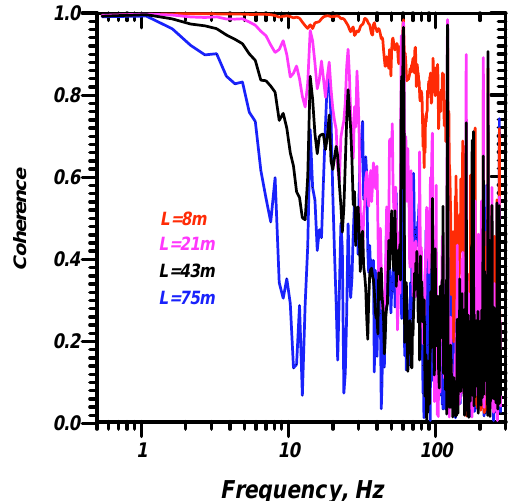
FIG. 17. (Color) Coherence of the ground motion vs distance. TARP measurements.